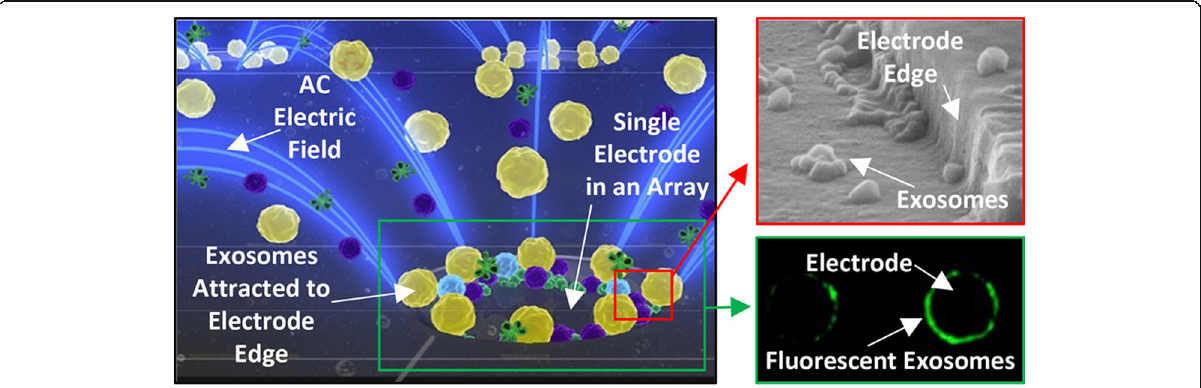
Fig. 3 ACE chip microelectrodes collect exosomes and other microvesicles [104]. Copyright© 2017, American Chemical